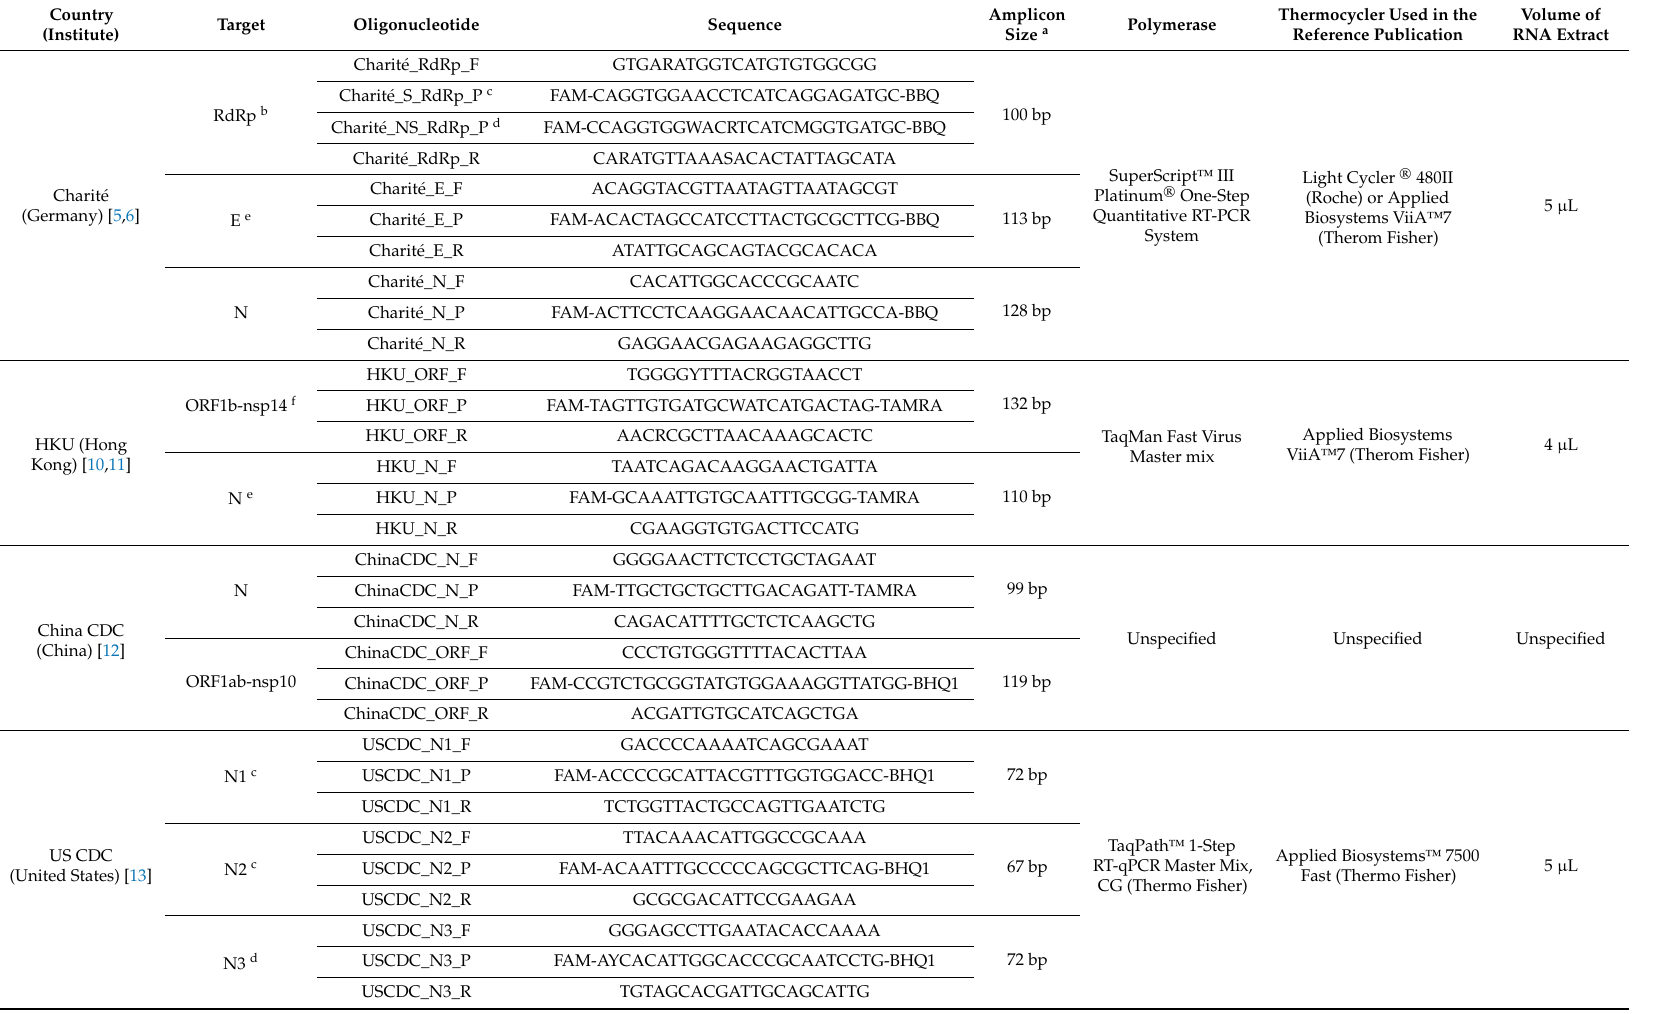
Table 1. Summary of the five RT-PCR assays targeting severe acute respiratory syndrome coronavirus 2